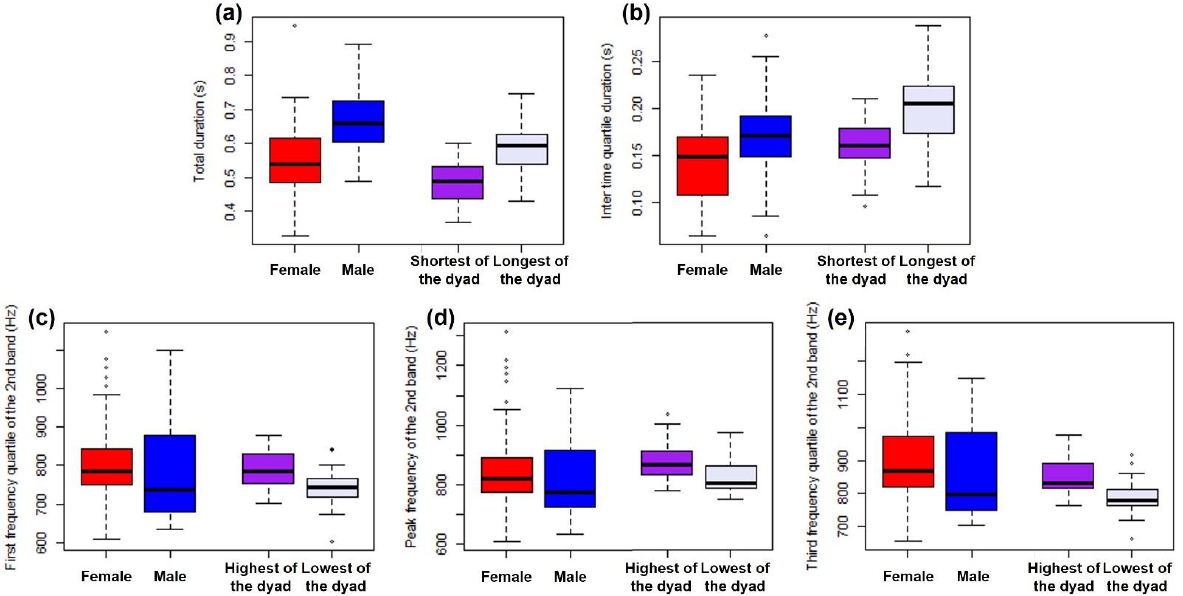
Figure 9. Acoustic parameters of maned wolf roar-barks analyzed separately for captive (recorded manually in 2 facilities at Minas Gerais state, Brazil) and for free ranging wolves (recorded passively in the Serra da Canastra National Park, MG/BR). In captivity the differences between females (red) and males (blue) were tested using a linear mixed model controlling for individual and sequence (males are longer, no other parameters significantly differ). The parameters of free ranging wolves were measured and paired within each dyad interactive roar-bark sequence (2 animals) using paired Wilcoxon tests. Individuals were only compared to the one they were interacting at the moment (participants differ significantly in all parameters). For visualization only, for each comparison the shortest in duration and highest in frequency of the dyad was set in the first box (purple) of the free ranging data and the other in the next box (lavender). ( a ) Total duration; ( b ) InterQuartile duration; ( c ) 1 st frequency quartile of the 2 nd band; ( d ) Peak frequency of the 2 nd band; and ( e ) 3 rd frequency quartile of the 2 nd band. 4. Discussion In this work we aimed to determine when and who engages in acoustic interactions in free-ranging maned wolves. Using passive acoustic monitoring we discovered that there were more interactive roar-bark sequences (two animals engaging in vocal ex- change) during the mating and initial parental care periods. This finding is in accordance with our prediction that interactive roar-bark sequences mediate intrafamilial group long- distance communication. We also found that participants of these interactive sequences differed in the acoustic parameters of their roar-barks, including their duration, which in captivity differed between males (longer) and females. Additionally, we found that in captivity, almost all roar-bark dyad sequences (two participants) were between a male and a female and interactive sequences with three or more participants always included both sexes. Taken together, our evidence indicates that maned wolves in our free-ranging recordings that are acoustically interacting at long distances are most likely male-female dyads. Maned wolves usually remain several hundred meters from each other [14], and fe- male estrus lasts only five days [26]. During estrus, long distance vocal exchanges could help receptive individuals to find each other to mate. Our findings suggest that when